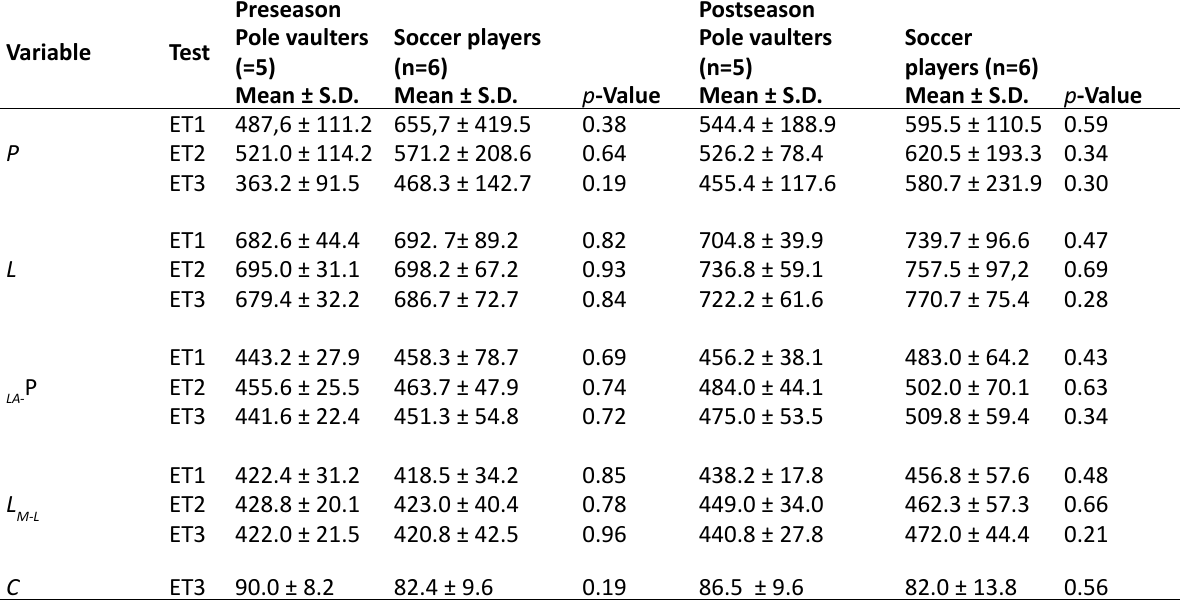
Table 2. Sway area, mean total length, path length in AP plane, path length in ML plane in pole vaulters and soccer players